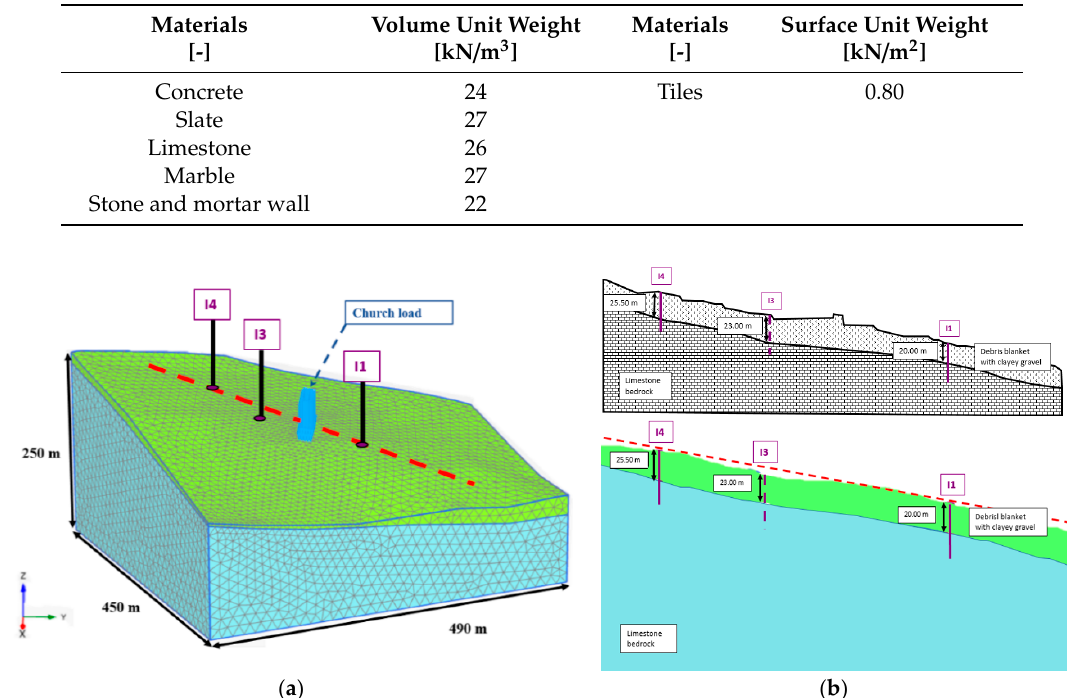
Table 2. Volume Unit Weight and Surface Unit Weight adopted for the evaluation of the church load.